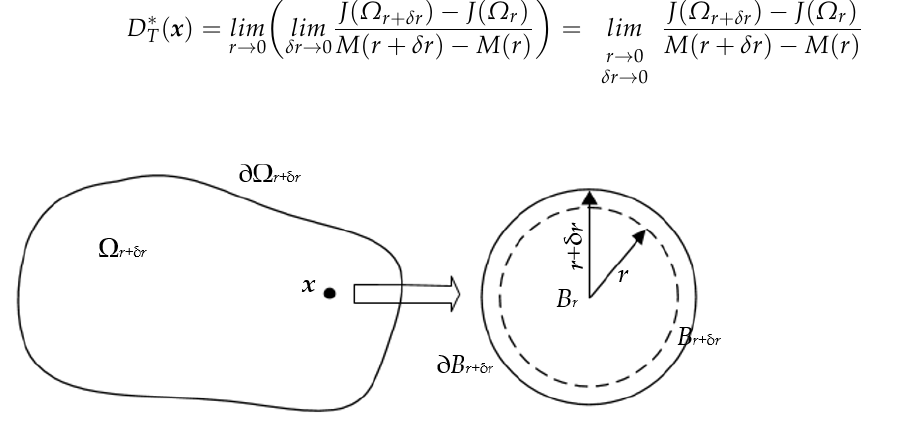
Figure 2. Modified definition of topological sensitivity.